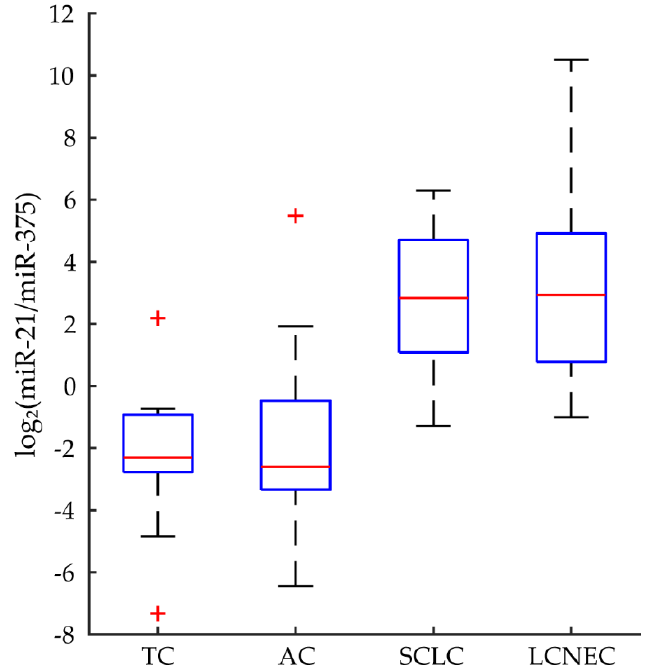
Figure 1. Ratio of miR-21 and miR-375 expression in lung NENs. Log 2 transformed ratios of miR-21 and miR-375 expression were assessed in all samples. Ratios were significantly lower in carcinoids than NECs (MWW, U = 66.0, p < 0.001, r = −0.825). Red crosses denote statistical outliers. Abbreviations: typical carcinoid (TC), atypical carcinoid (AC), small cell lung carcinoma (SCLC), large cell neuroendocrine carcinoma (LCNEC).